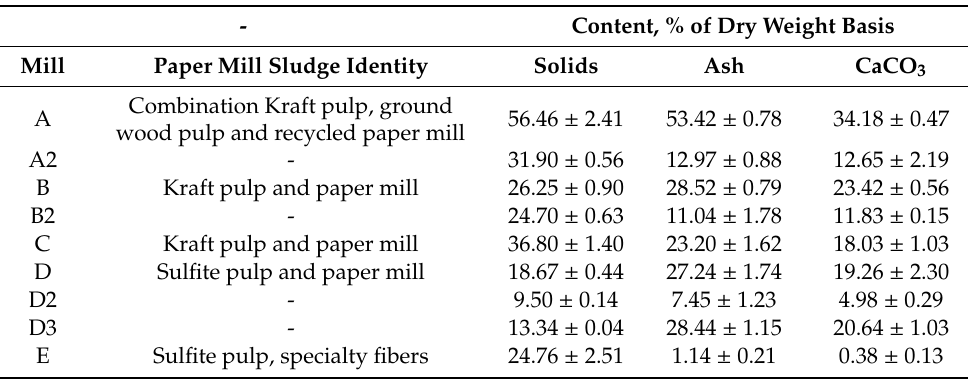
Table 1. Mill labels and types of pulp produced. Characterization of solids content, inorganic and calcium carbonate content of mill sludge samples. A, B, C, D, E unwashed, A2, B2, D2, HCl washed and D3 water washed. Inorganic and calcium carbonate content expressed as a percentage of total biomass dry weight ( ± S.D.) ( n =